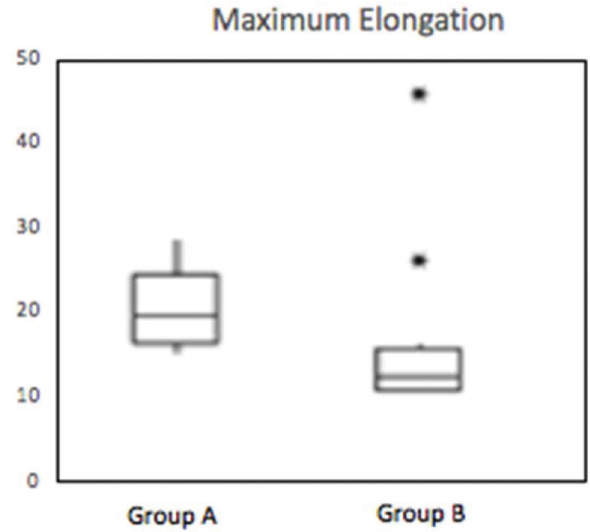
Figure 6 - Box-plot demonstrating the distribution of the maxi- mum force (N) of groups A and B ( p